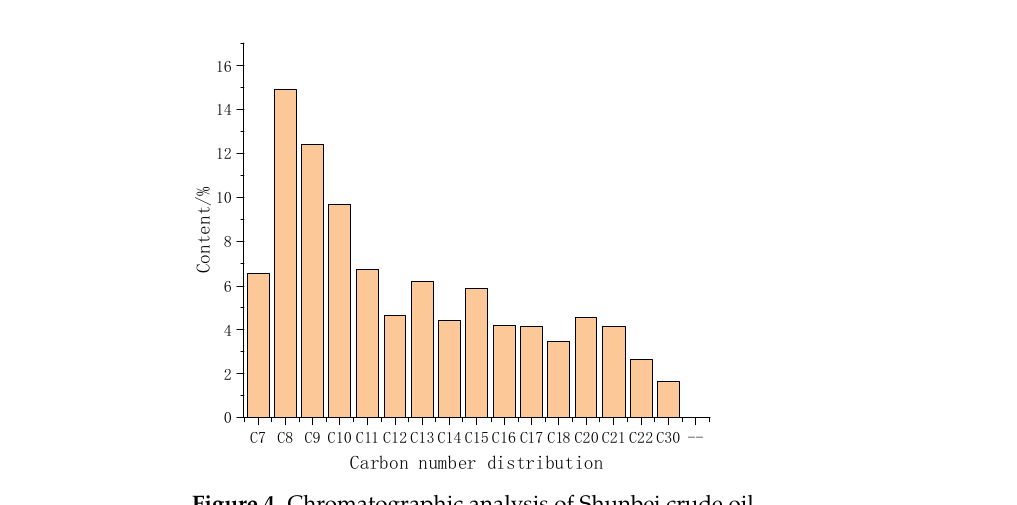
Figure 4. Chromatographic analysis of Shunbei crude oil.